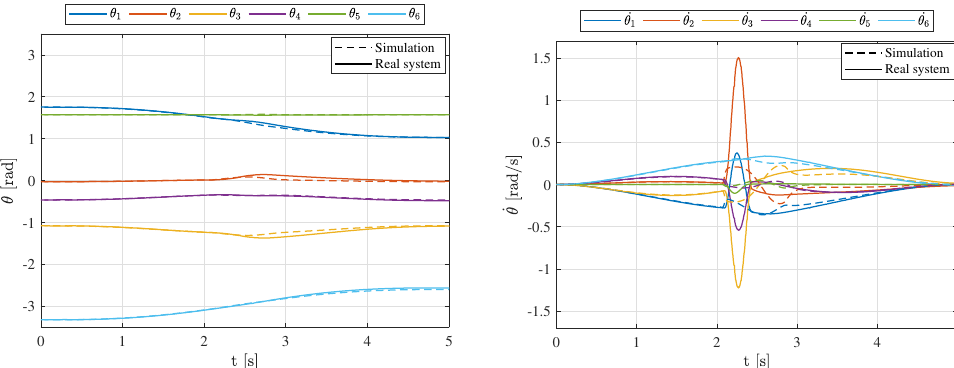
Figure 8. Test case 2, Mode I. Joint rotations( left ) and speeds ( right ).